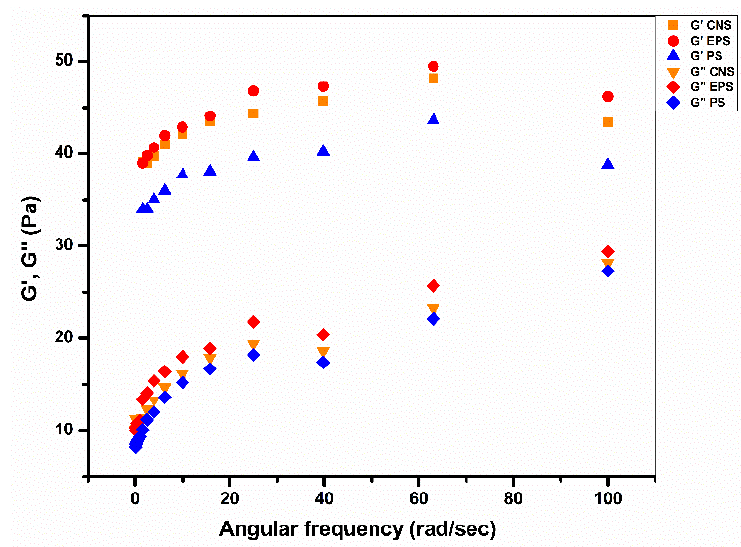
Figure 4. Rheological behavior of untreated and CLSs.